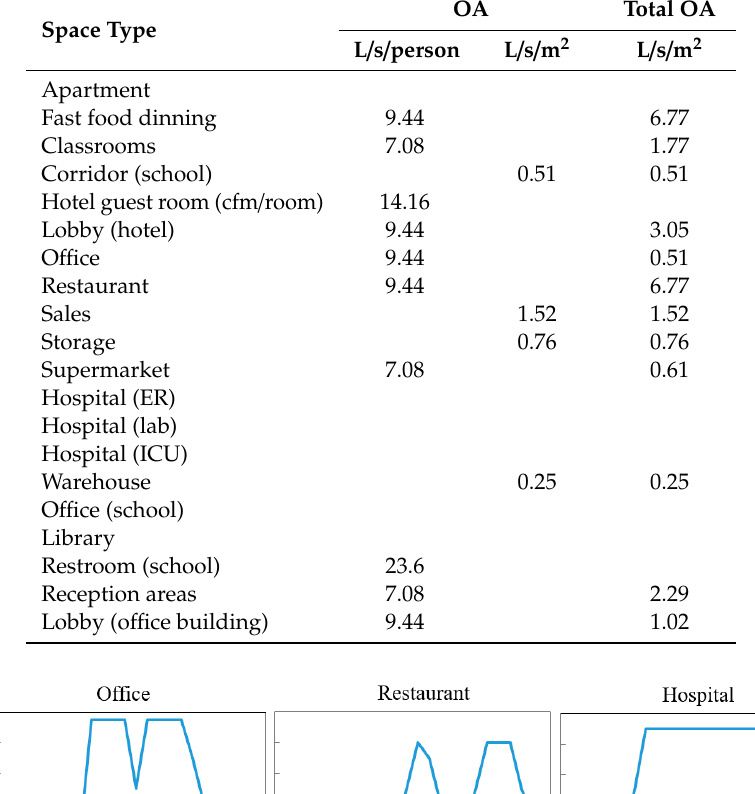
Table 3. Outside air requirements (ventilation) [48].